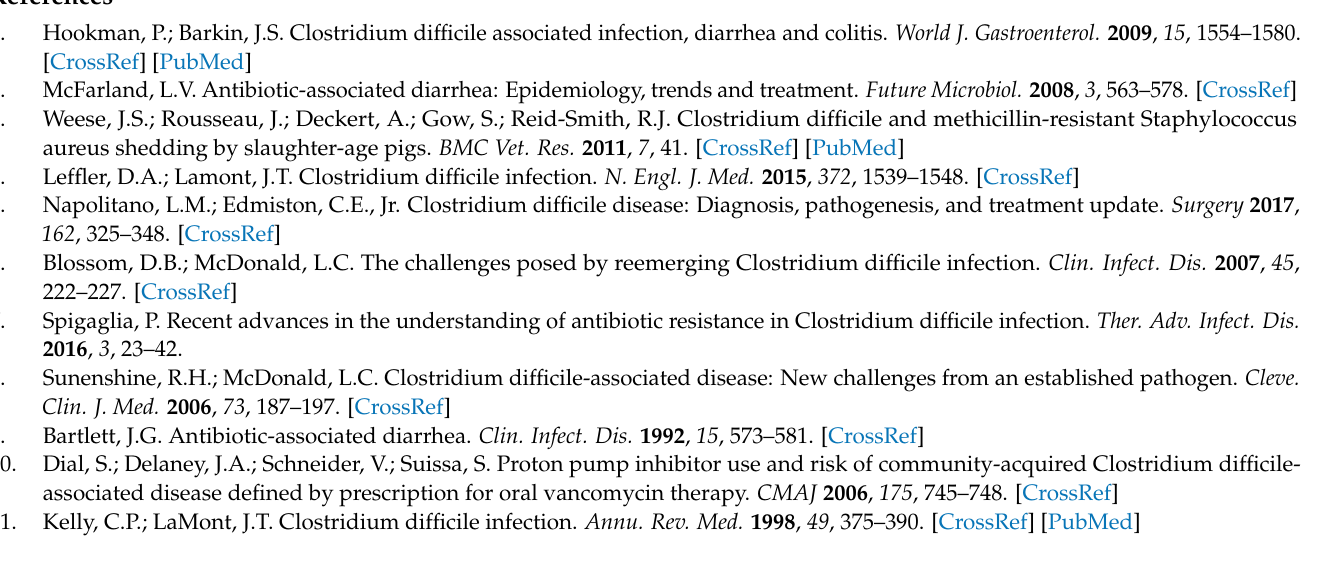
body condition chart, Table S1: Mouse clinical score sheet, Figure S3: Mouse survival